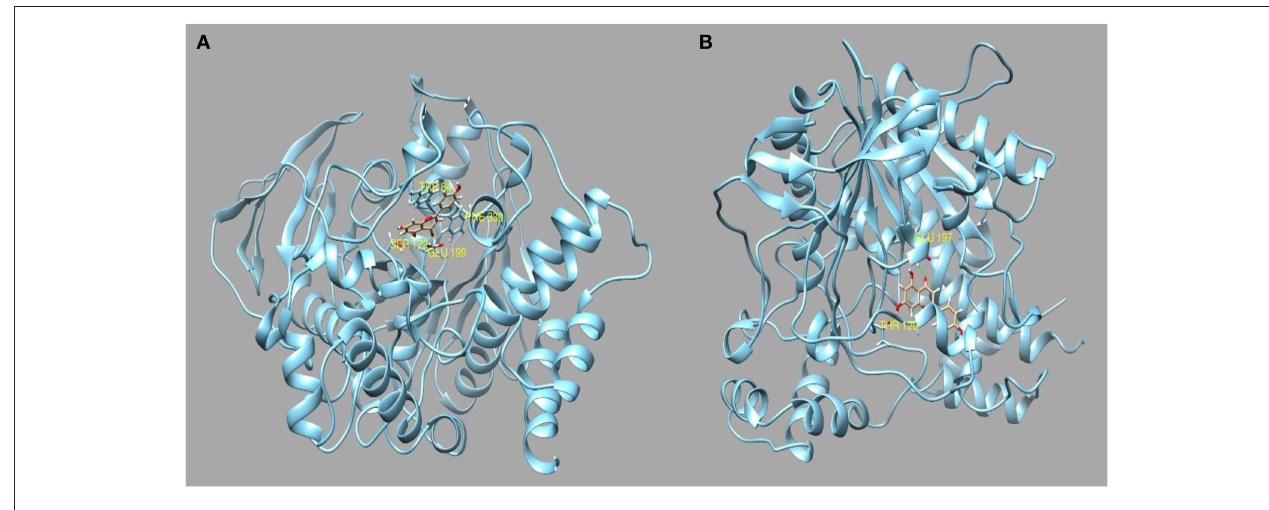
FIGURE 2 | (A) Best pose of apigenin docked to AChE and (B) to BChE.